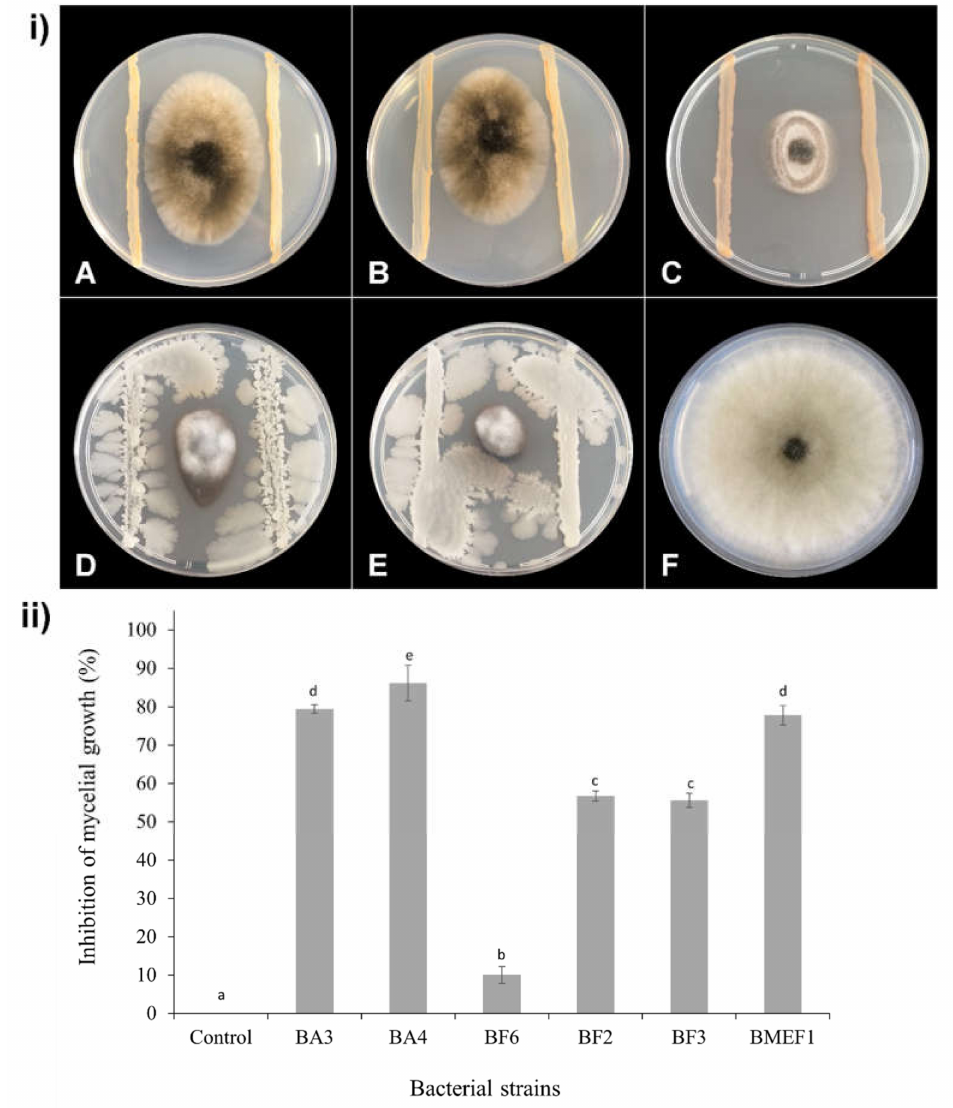
Figure 2. ( i ) In vitro inhibitory activities of isolated bacteria against A. alternata on PDA medium after 7 days of incubation at 25 ◦ C.Plates inoculated with the pathogen and bacterial strains: Rosenbergiella epipactidis BF2 (A), Rosenbergiella epipactidis BF3 (B), A. spathodeae BMEF1 (C), B. velezensis BA3 (D), B. velezensis BA4 (E), respectively. (F) Control plate inoculated only with the fungus. ( ii ) Growth inhibition of A. alternata confronted with bacterial isolates in dual culture assay. Different letters above the bars indicate significant differences according to Tukey’s test ( p <